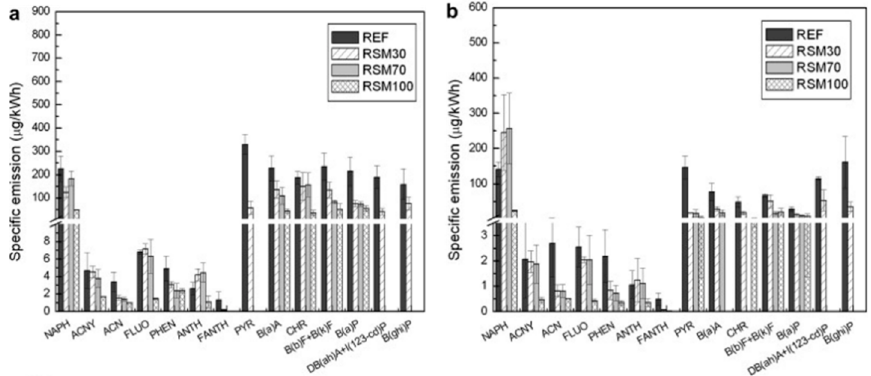
Figure 15. Polycyclic aromatic hydrocarbon (PAH) emissions in urban mode ( a ) and extra-urban mode ( b ) for rapeseed methyl esters fuels (adapted with permission from [13], Elsevier, 2010).